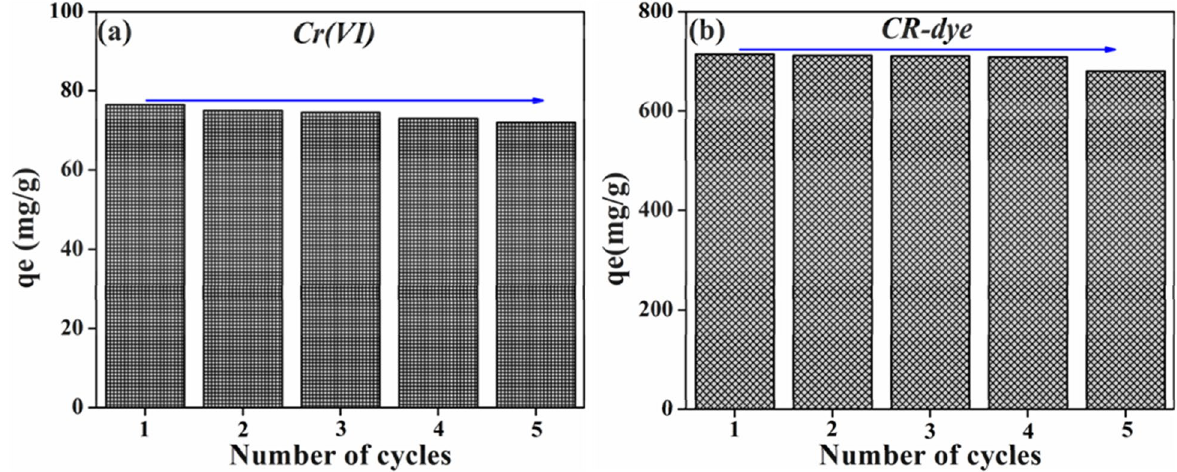
Figure 9. Cycling stability of PMC materials against ( a ) Cr(VI), and ( b ) CR-dye.